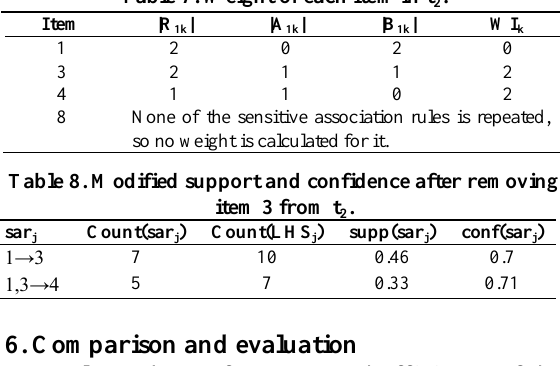
Table 7. Weight of each item in t 2 .